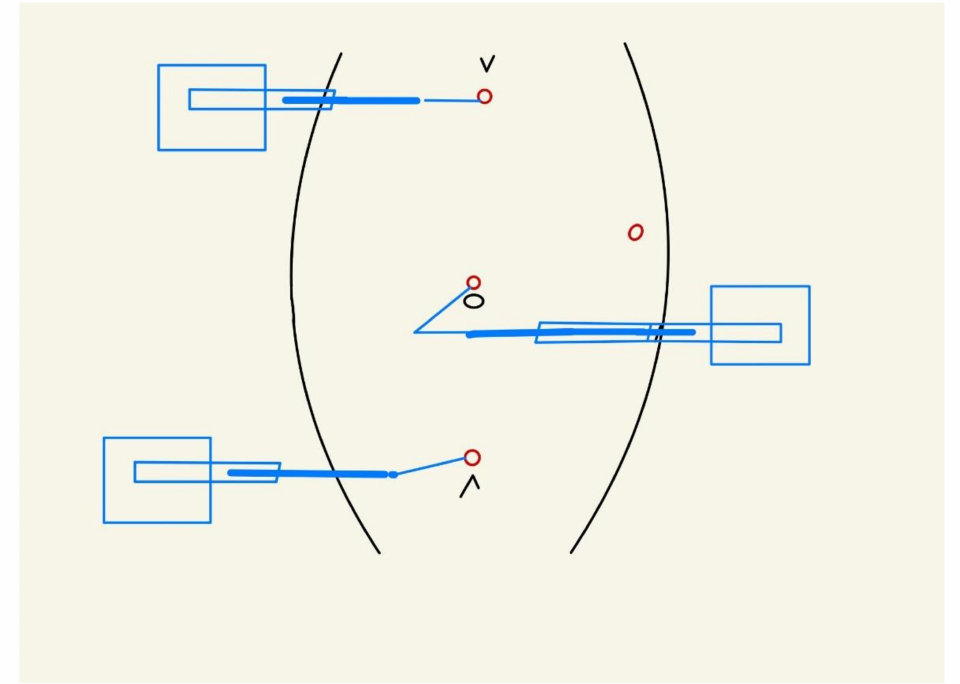
Figure 3. Placement of ports and Senhance ® robot arms in a three-arm setting. The right robotic working arm is placed at the patient’s right side with a suprapubic 5 mm port; the left robotic working arm is placed at patient’s right side with a subxiphoid 5 mm port. The camera arm is placed at the patient’s left side with a 5 mm umbilical port, and works “overhead” with the instrument coming from the patient’s right side. One additional auxiliary 5 mm port is placed at the left abdominal